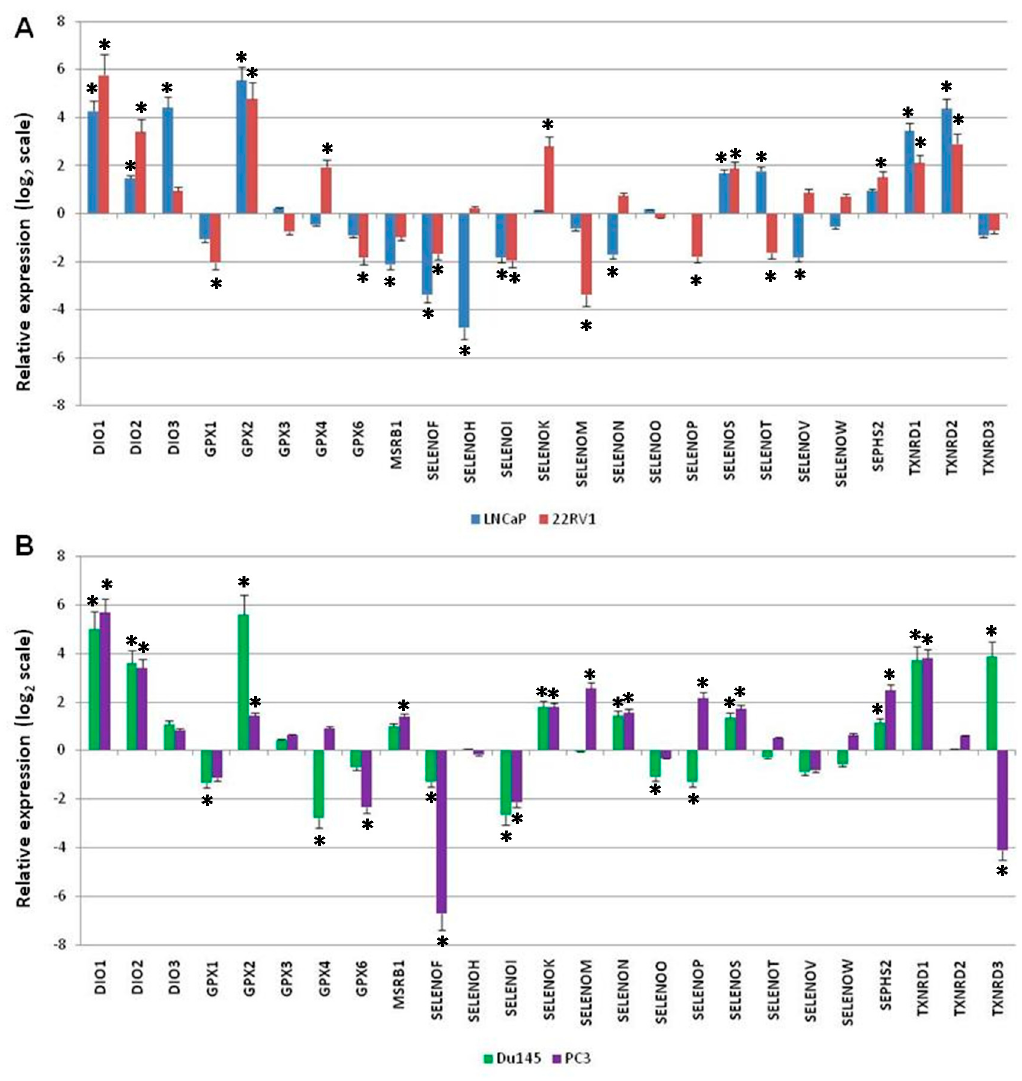
Figure 4. Fold change of gene expression level for each selenoprotein (indicated as the relative expression) in ( A ) two androgen receptor-positive (LNCaP and 22RV1) and ( B ) two androgen receptor-negative (DU145 and PC3) prostate cancer line cells, compared to the non-cancerous epithelial cells (EPN) cells, as evaluated by the 2 −ΔΔ Cq method, and reported on the log 2 scale. We considered values higher and lower than +1 and − 1 to be statistically significant, respectively. The statistically significant p -values at <0.05 are indicated by *.